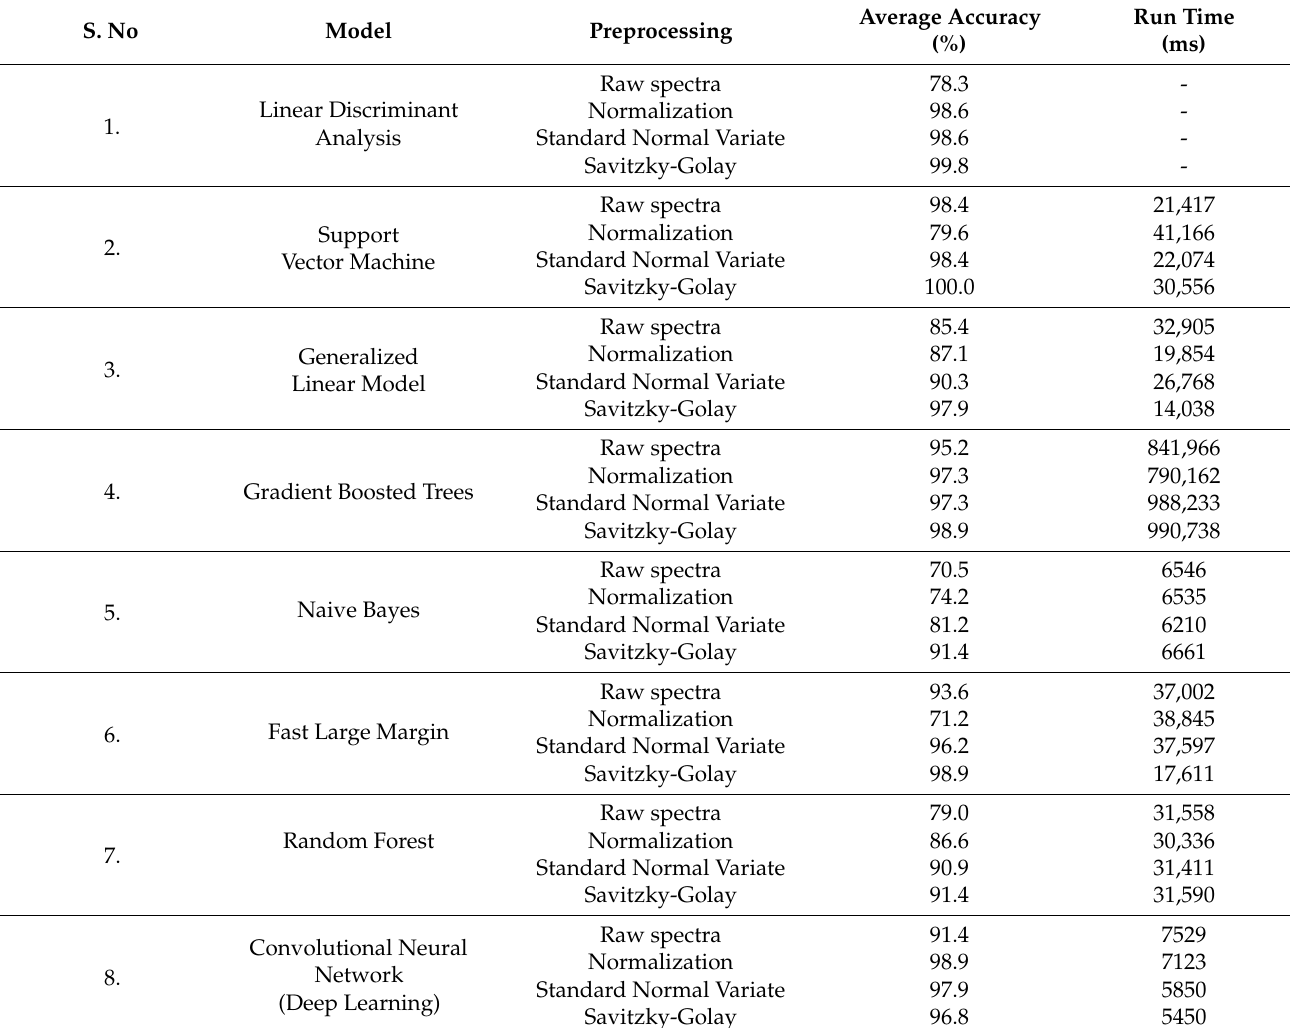
Table 1. Classification accuracy of the combinations of preprocessing and model for reflectance spectra from B. napus , GM B. napus , B. rapa and F1